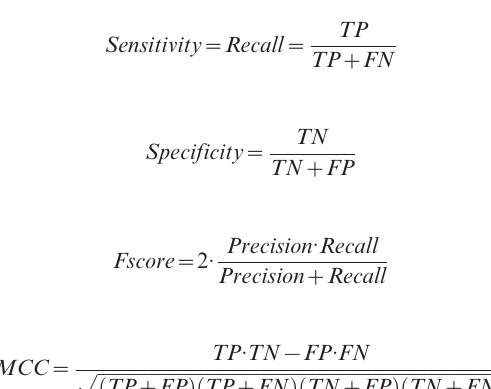
Table S1db Performance of SIFT. (1) All Blosum62 data